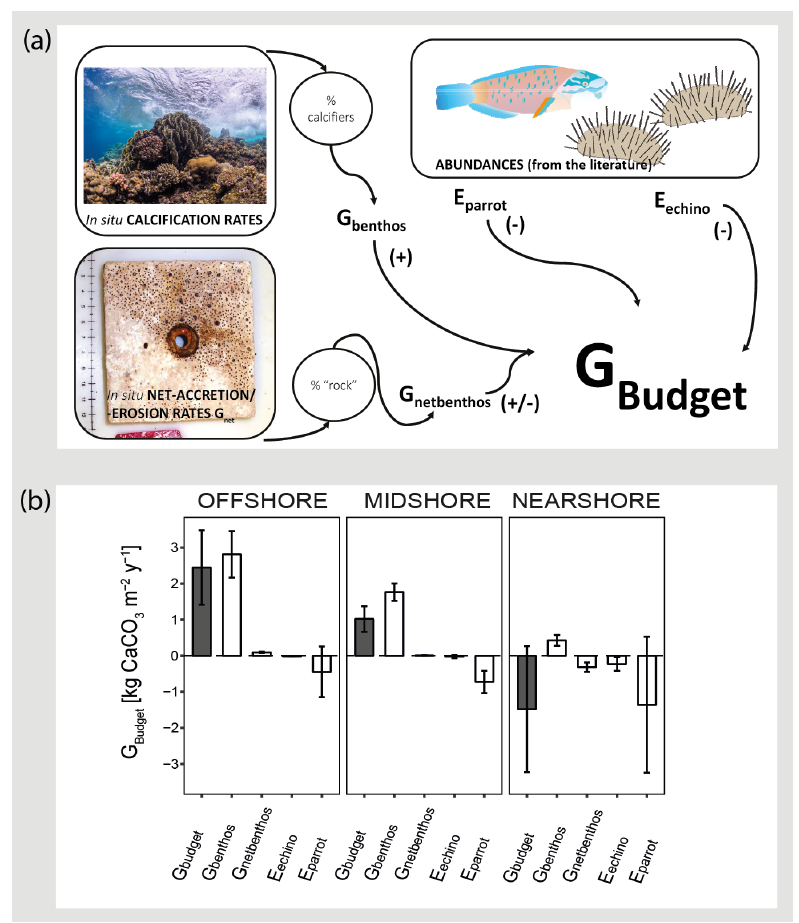
Figure 3. Census-based carbonate budgets in the central Red Sea. A schematic overview of the census-based carbonate budget approach that was adapted from the ReefBudget methodology by Perry et al. (2012) is displayed in (a) . Details on input data and equations, employed in the calculations, are available as the Supplement (Text S1 and the respective Supplement Tables). In (b) reef carbonate budgets are plotted in dark grey ( G budget ) and related biotic variables in white. The biotic variables, i.e., site-specific calcification rates of benthic communities ( G benthos ), net-accretion/-erosion rates of reef “rock” surface area ( G netbenthos ), and the epilithic erosion rates of echinoids and parrotfish ( E echino , E parrot ) contribute to the total reef carbonate budget ( G budget ) at each reef site. All data are presented as means ± standard deviations. Images from http://www.ian.umces.edu; last access: 1 April2016; photos by Anna